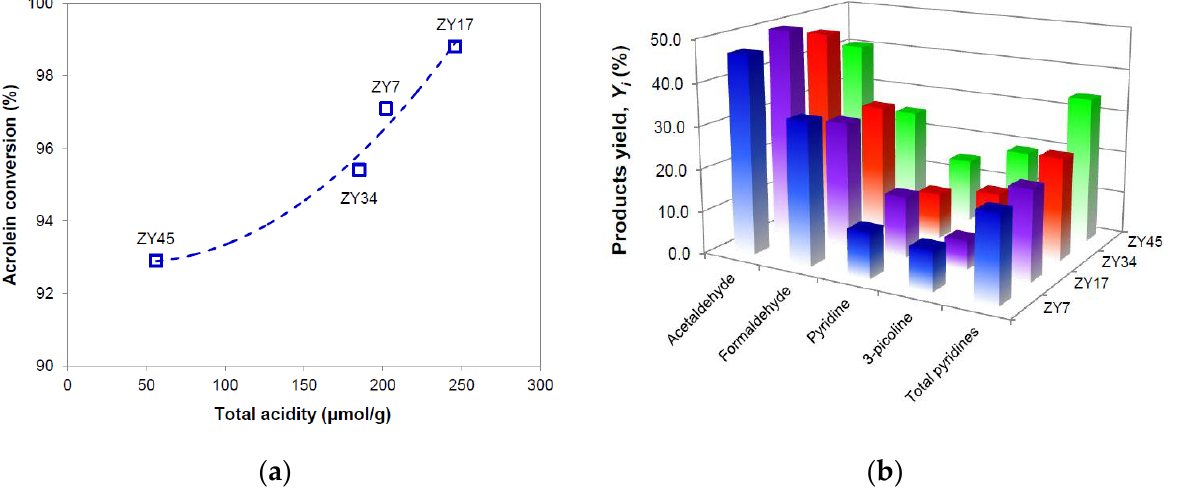
Figure 7. ( a ) Initial acrolein conversion and, ( b ) initial products yield of the reaction between acrolein and ammonia over the Y-type zeolites. The total yield of pyridine bases = (pyridine + 3-picoline). Reaction conditions: T = 360 ◦ C, molar ratio NH 3 /acrolein = 2, GHSV = 4994 h − 1 , TOS = 5 min.